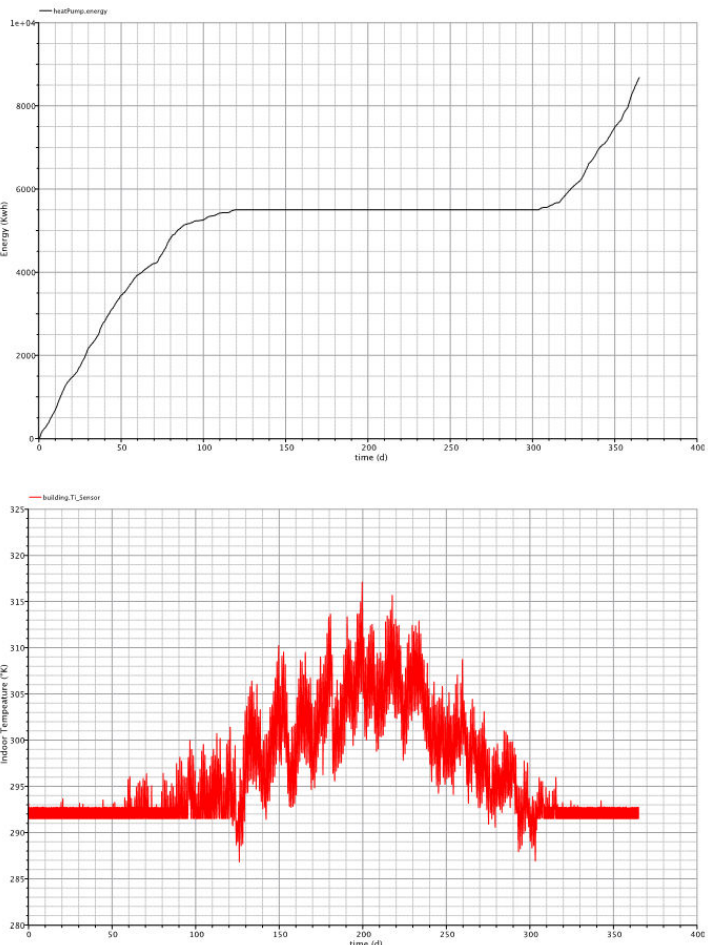
Figure 5. The graphs of the simulation of the initial assessment, obtained by OpenModelica 17.0 using the Buildings 7.0.0 library. ( Top ) the consumption trend, ( bottom ) the internal temperature